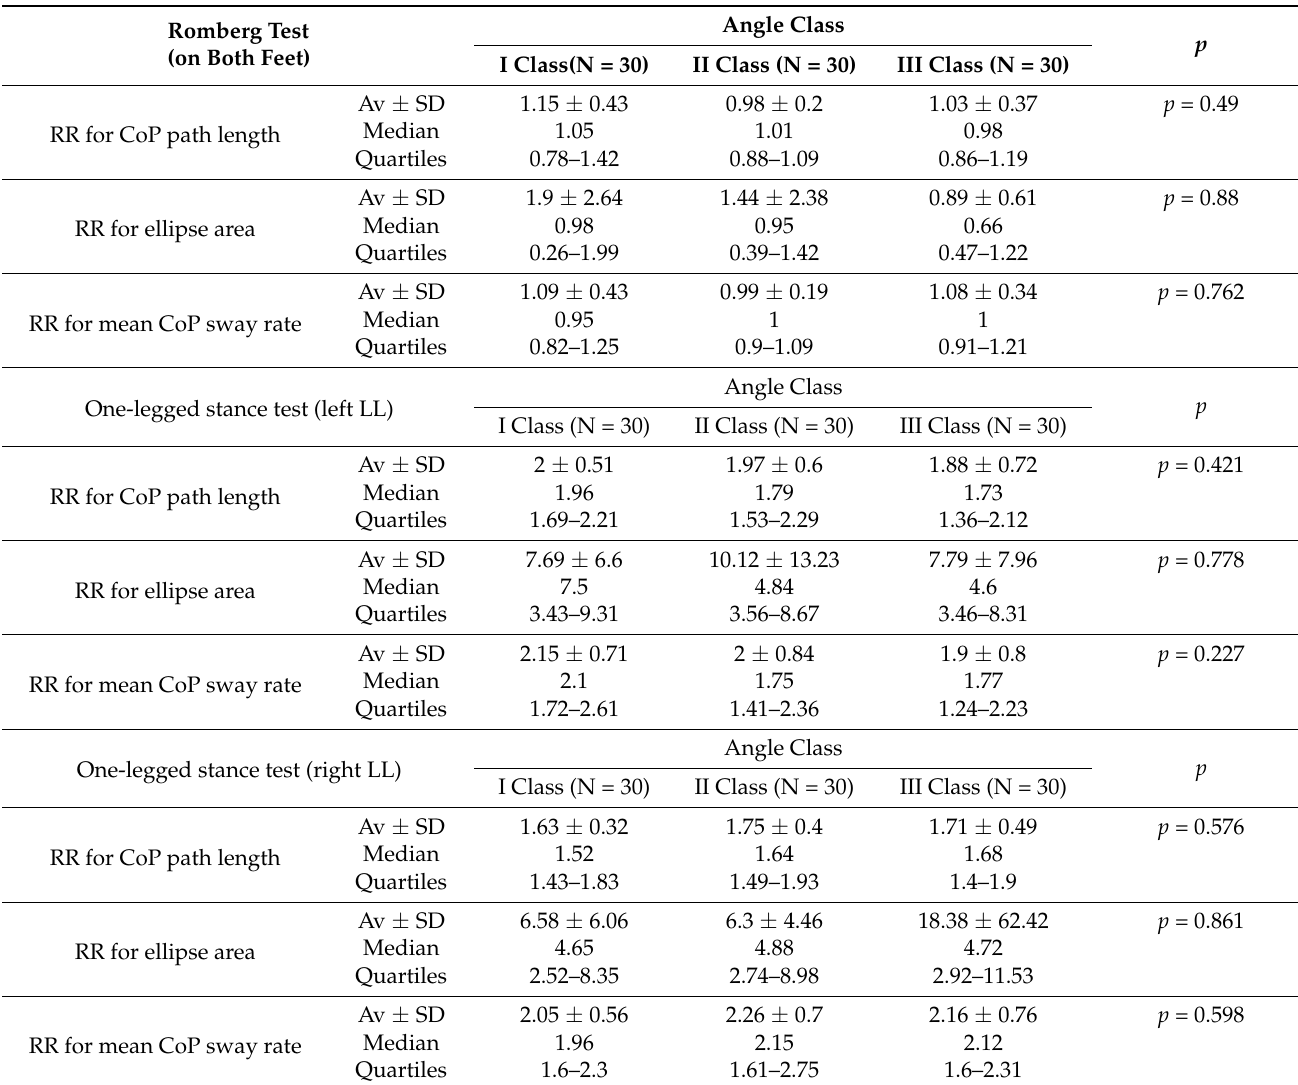
Table 7. Romberg’s ratio values for parameters obtained in stabilographic